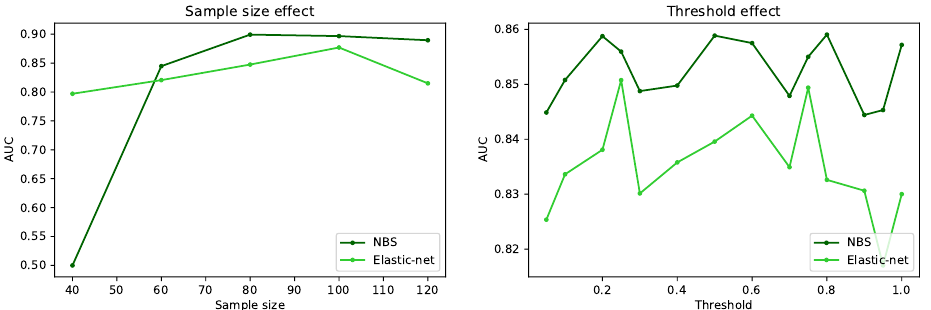
Figure 4. Evolution of the classification score, in terms of AUC, as a function of the sample size (number of subjects in the dataset, ( left panel )) and of the proportional threshold applied to the net- work ( right panel ). Black and green lines respectively correspond to the NBS and Elastic-net link selection